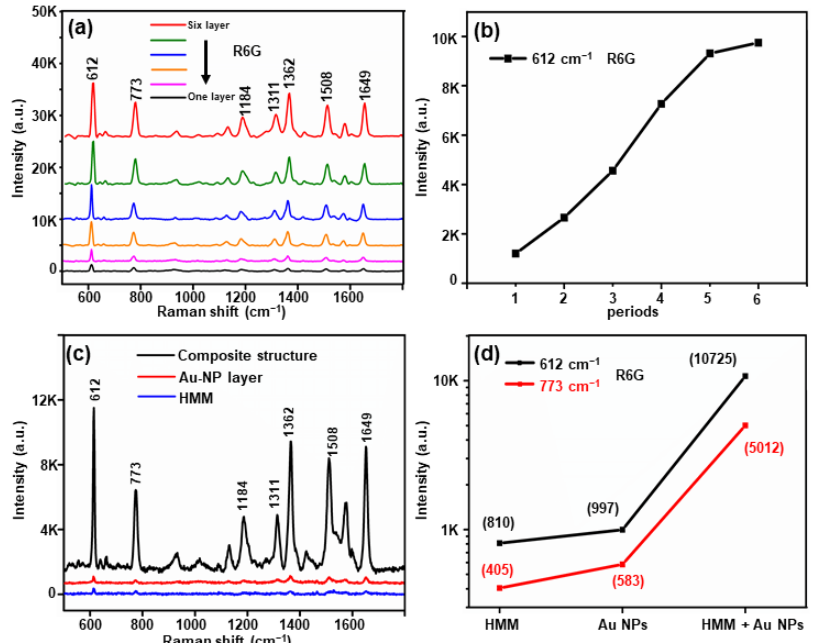
Figure 5. ( a ) The Raman signal of 10 −6 M rhodamine 6G (R6G) on HMM, Au-NP layer, and composite structure with six Au/Al 2 O 3 bilayers. ( b ) The Raman signal intensity of characteristic peak at 612 cm −1 in different periods. ( c ) The relationship diagram of the peak intensity of the R6G Raman spectra at 612 and 773 cm −1 . ( d ) The Raman spectra of 10 −6 M R6G from the different structures. Additionally, reproducibility was considered to be an essential indicator for examin- ing the SERS substrate performance. As shown in Figure 6a, 15 spots from composite structures were taken randomly, and the Raman signal was collected for 10 −6 M R6G. No significant fluctuations for each characteristic peak of R6G were observed from the data. The distribution histogram of the intensity of the characteristic peak at 612 cm −1 for R6G is provided in Figure 6b, where the black horizontal line represents the average intensity